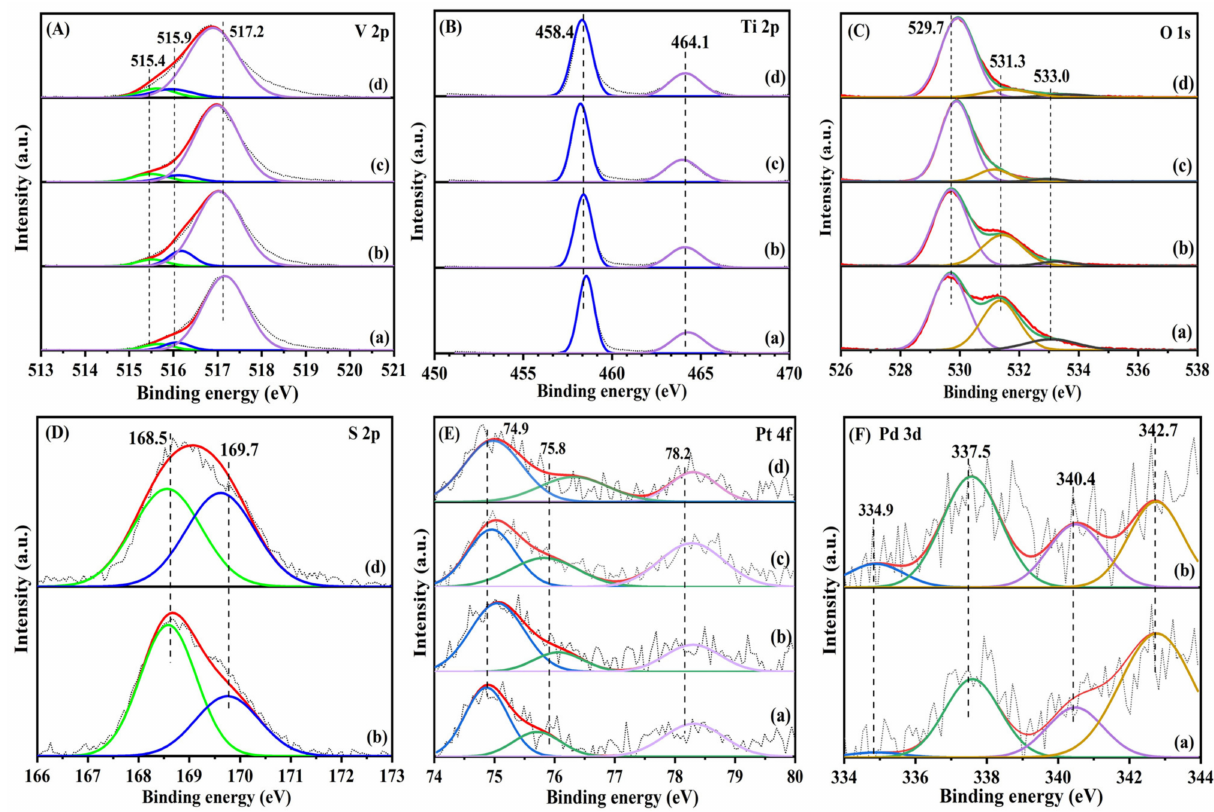
Figure 5. ( A ) V 2p, ( B ) Ti 2p, ( C ) O 1s, ( D ) S 2p, ( E ) Pt 4f, and ( F ) Pd 3d XPS spectra of (a) fresh 0.46PdPt 2.10 /V 2 O 5 -TiO 2 , (b) 0.46PdPt 2.10 /V 2 O 5 -TiO 2 after SO 2 treatment, (c) fresh 0.47Pt/V 2 O 5 -TiO 2 , and (d) 0.47Pt/V 2 O 5 -TiO 2 after SO 2